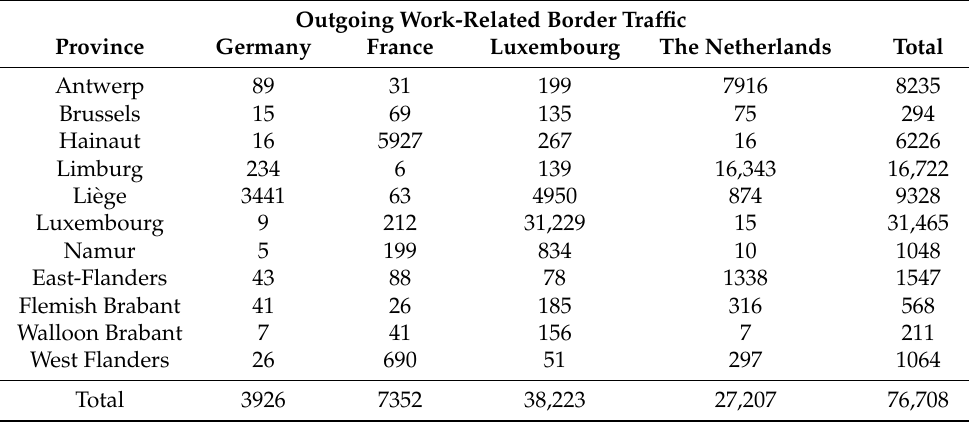
Table 1. Number of people living in Belgium but working in a neighboring country. Outgoing Work-Related Border